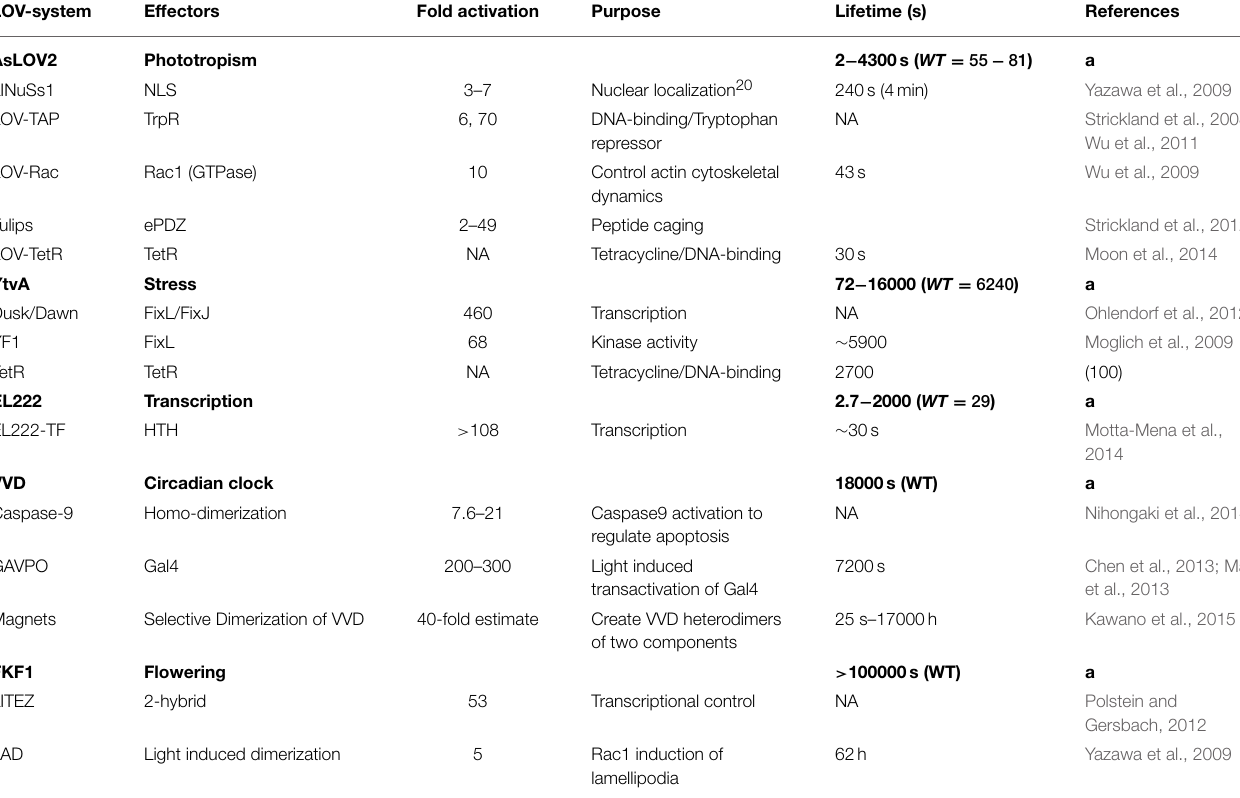
TABLE 1 | Selected LOV-based optogenetic